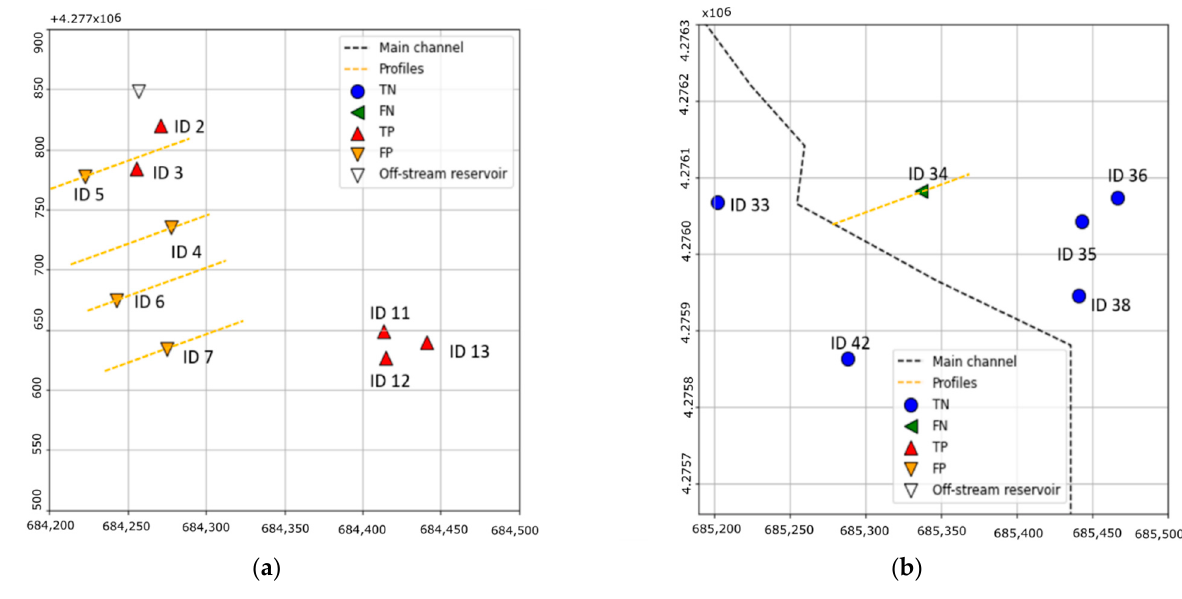
Figure 17. Zoom in areas with misclassified AoI and location of cross sections: ( a ) FP; ( b ) FN. Axes represent UTM coordinates.